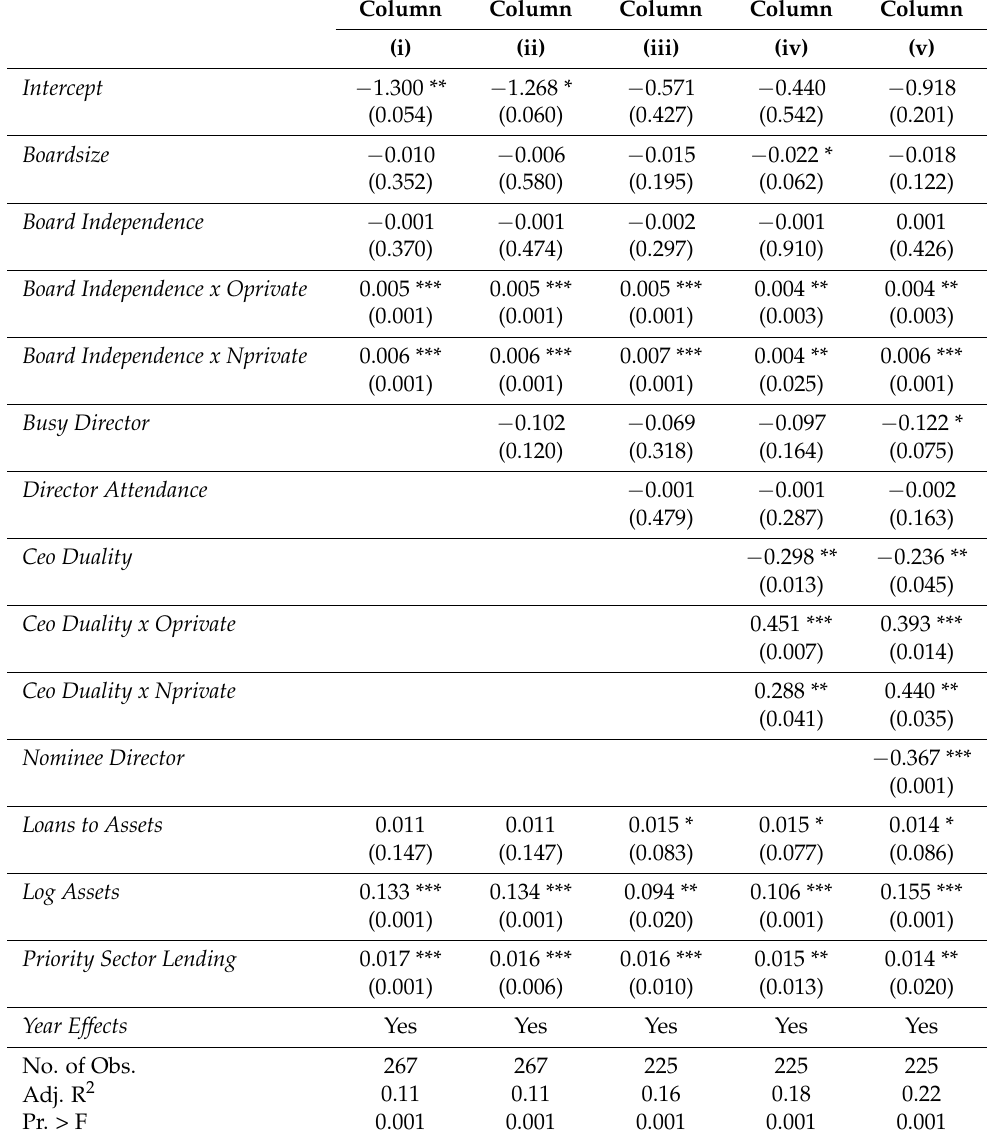
Table 4. Board Characteristics and Profitability: (Dependent Variable—Return on